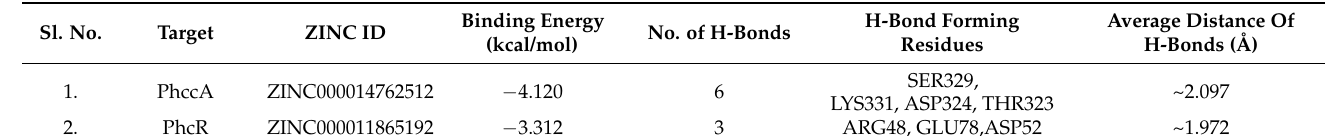
Table 3. Molecular docking of ZINC000014762512 and ZINC000011865192 with PhcA and PhcR using Glide.